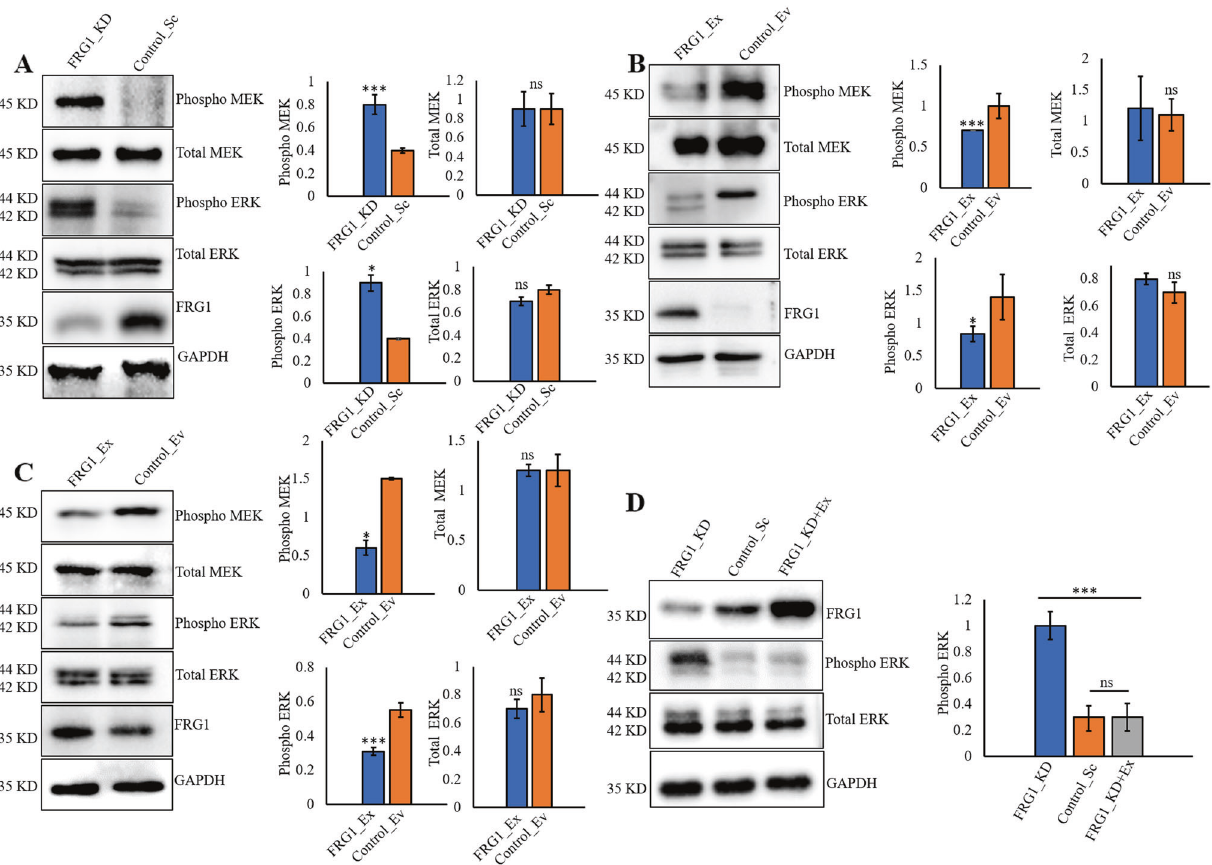
Fig. 2 Effect of FRG1 expression modulation on MEK/ERK signaling axis. The expression of pERK and pMEK in MCF7 and MDA-MB-231 cells with altered FRG1 expression was examined by Western blots. A – D Representative Western blots and the densitometry-based bar graphs for A the difference in pERK and pMEK levels due to FRG1 knockdown (FRG1_KD vs. Control_Sc), B the difference in the activation of ERK and MEK in MCF7 cells with elevated FRG1 expression (FRG1_Ex vs. Control_Ev), C expression of pERK and pMEK in MDA-MB-231 cells ectopically expressing FRG1 (FRG1_Ex) and its control (Control_Ev), and D rescue of pERK levels in MCF7_KD cell transiently transfected with the FRG1 expression vector (FRG1_KD + Ex). Experiments were performed in triplicates. The intensity of the bands in each blot was measured by